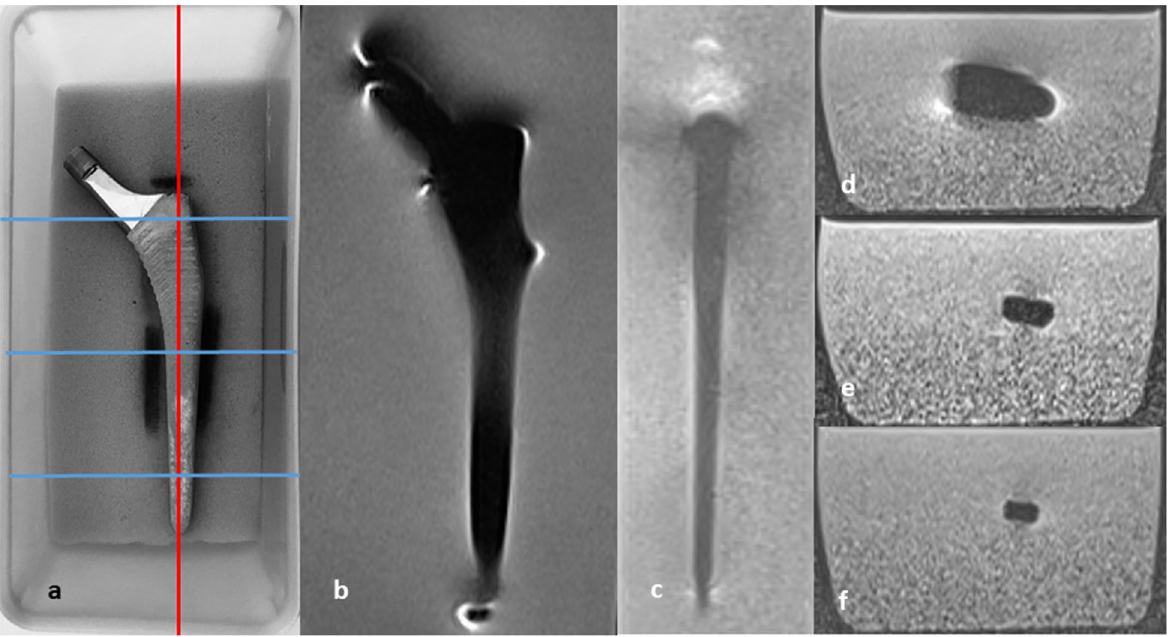
Fig. 1 Femoral component on a foam pad within a water phantom ( a ). Corresponding slice positions in coronal ( b ), sagittal ( c ; red line in a ), and three axial planes ( d , e , f ; blue lines in a ) predefined as reference for visual and quantitative assessment